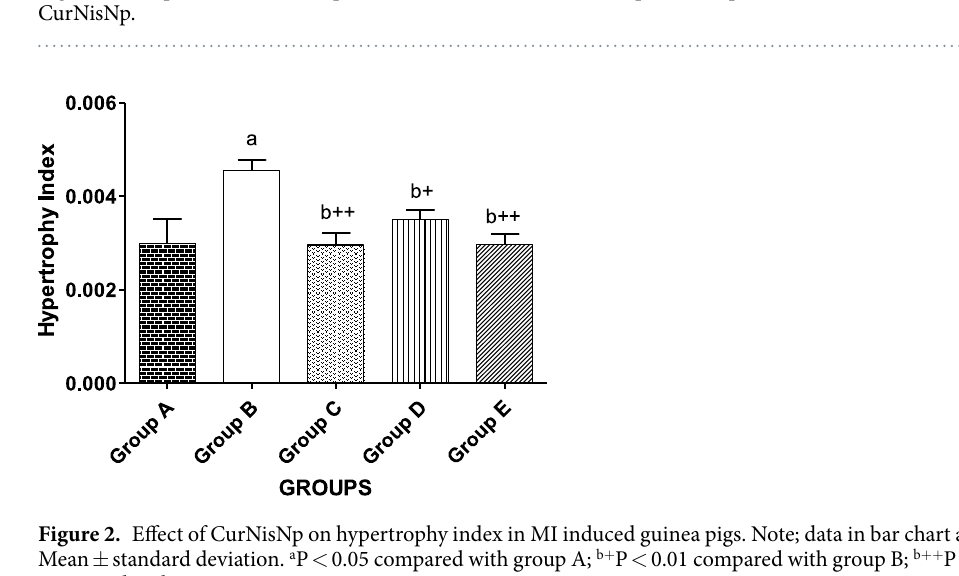
Figure 1. Properties of CurNisNp ( a ) Size distribution of CurNisNp ( b ) Zeta potential distribution of CurNisNp.